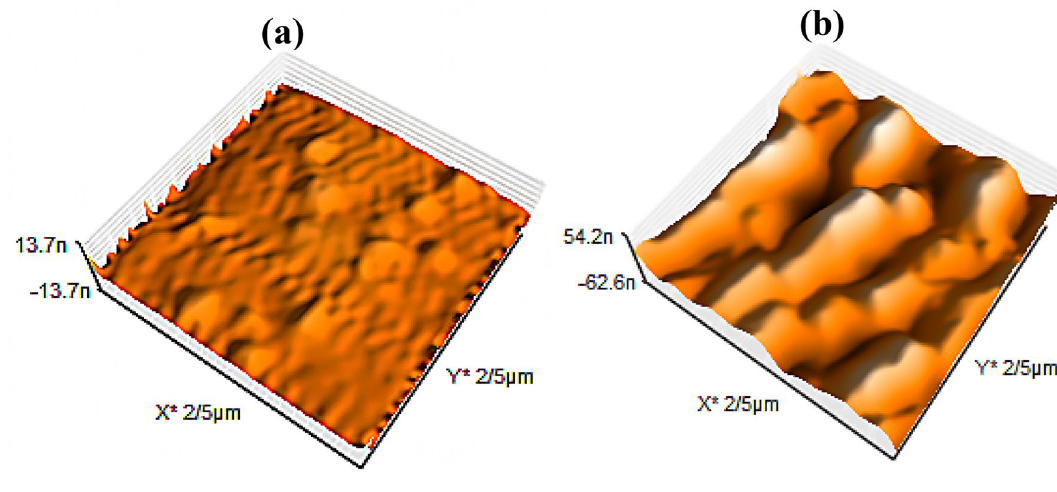
Figure 4. AFM images of ( a ) untreated ( b ) argon plasma-treated DR1 dye-doped PMMA surface for 300 s modification.